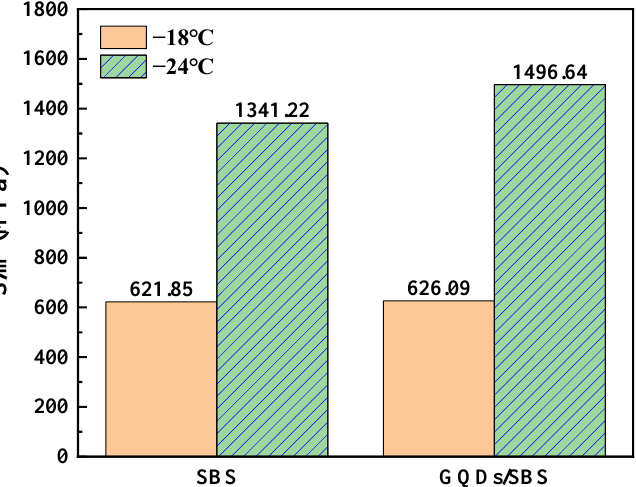
Figure 14. The ratio of creep stiffness S and m of SBS-modified asphalt and GQDs/SBS composite- modified